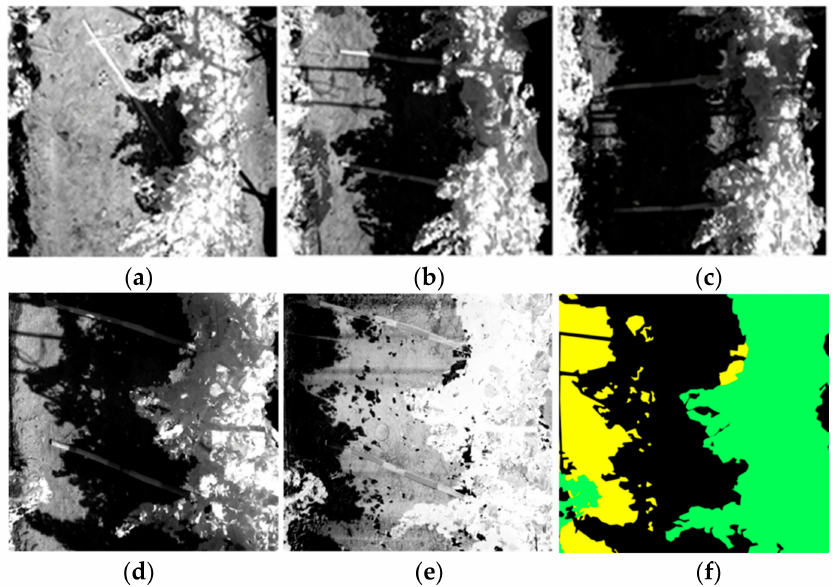
Figure 4. A sequence of NIR images of the same site captured along the day. ( a ) 14:26 PM (39 min after solar noon), ( b ) 16:07 PM, and ( c ) 17:07 PM. Solar Elevation was 62.7 ◦ ; 48.3 ◦ ; and 36.8 ◦ , respectively. ( d ) Near-infrared (NIR) nadir-viewing image of a VSP row, ( e ) NDVI of the same site and ( f ) Fractions of canopy (green), shaded soil (black), and sunlit soil (yellow). The frame was taken at 16:03 in Block 01 (Row Orientation of 13 ◦ East of True North), with the sun elevation at 49 ◦ and a relative azimuth of 70.8 ◦